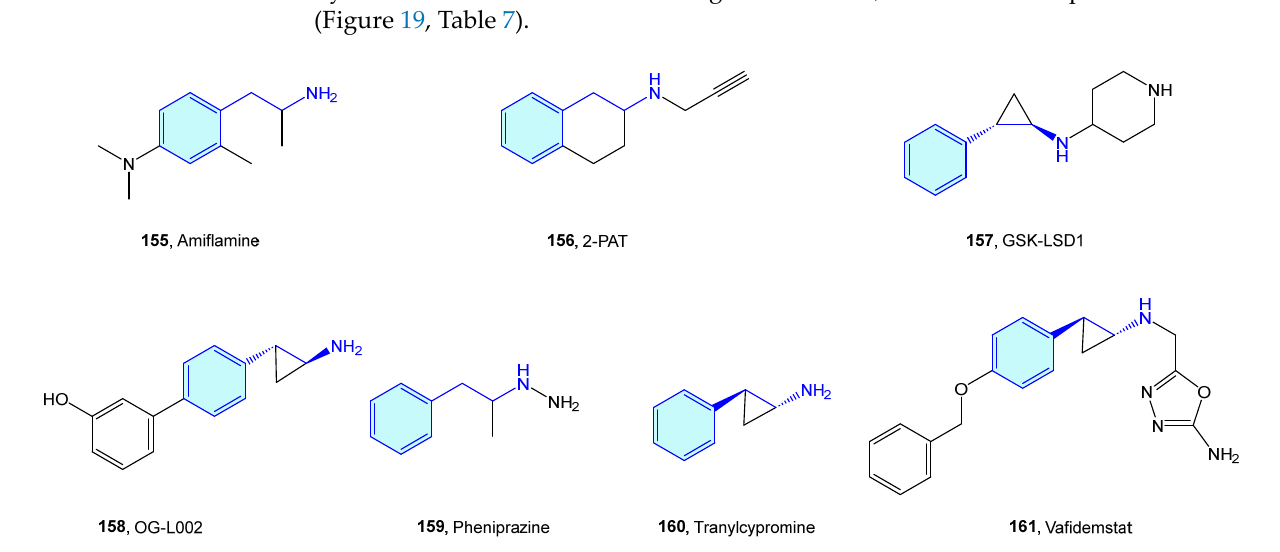
Figure 19 . 2-Phenethylamine MAO medicinal chemistry leads. Figure 19. 2‑Phenethylamine MAO medicinal chemistry leads. Table 7. MAO medicinal chemistry leads. Table 7. MAO medicinal chemistry